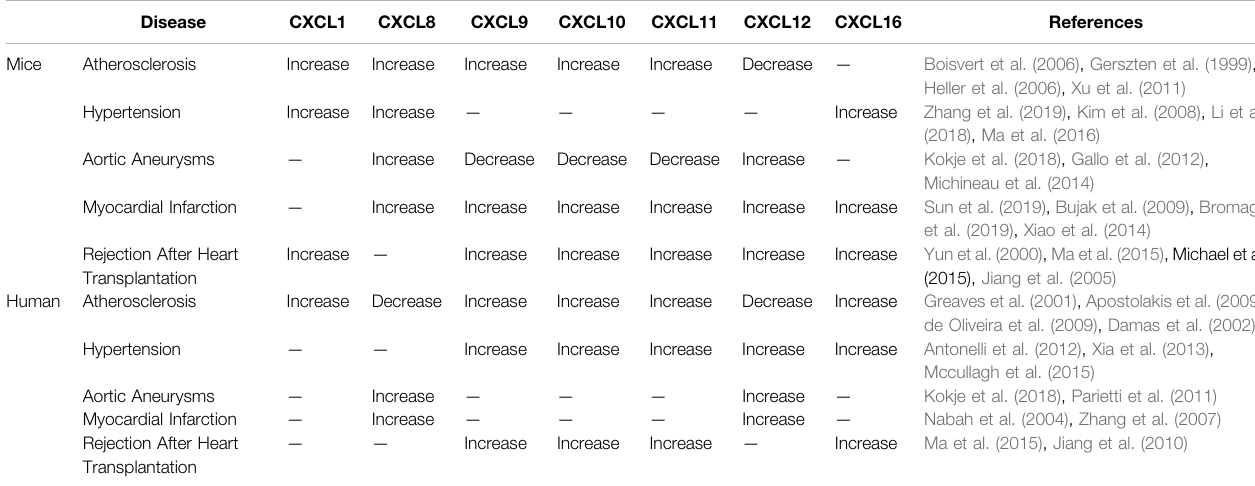
TABLE 3 | Expression of several common CXC chemokines in cardiovascular diseases.